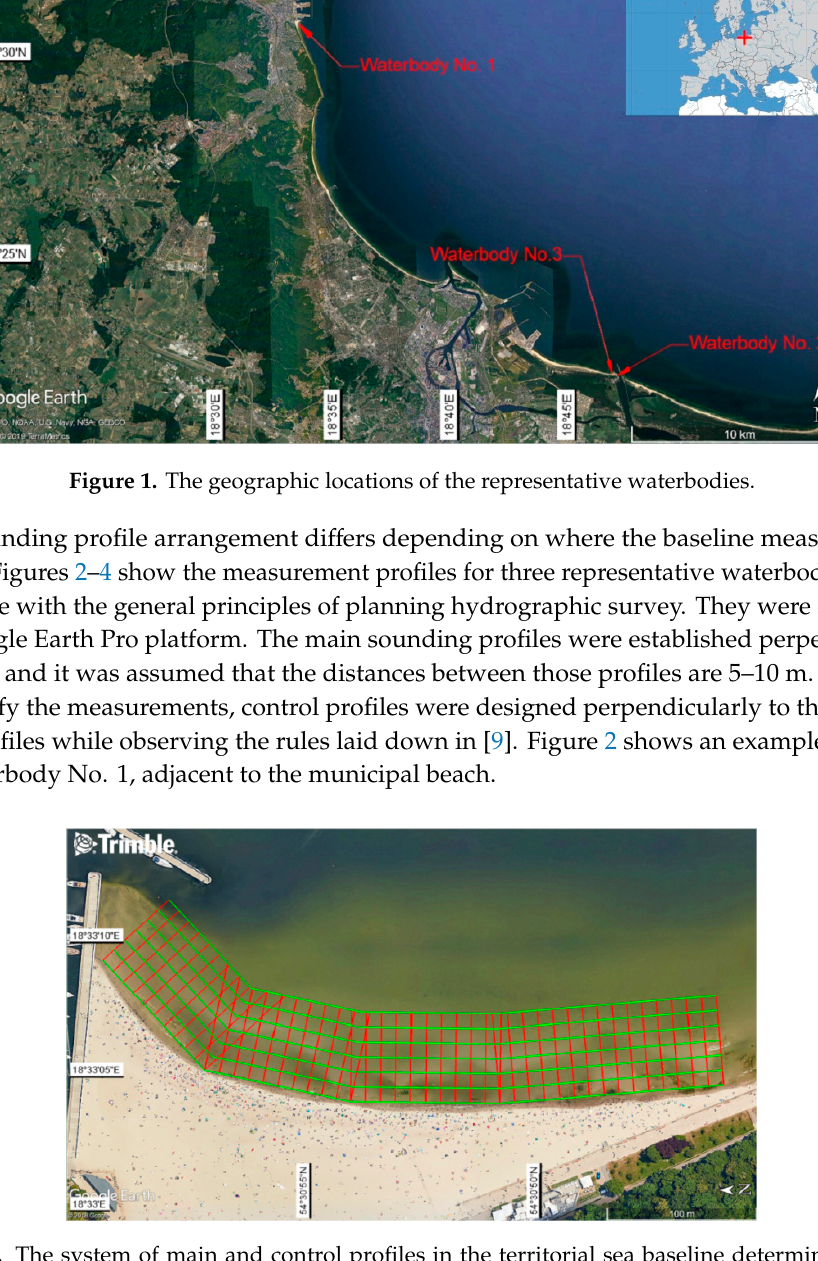
Figure 2. The system of main and control profiles in the territorial sea baseline determination for waterbody No. 1.